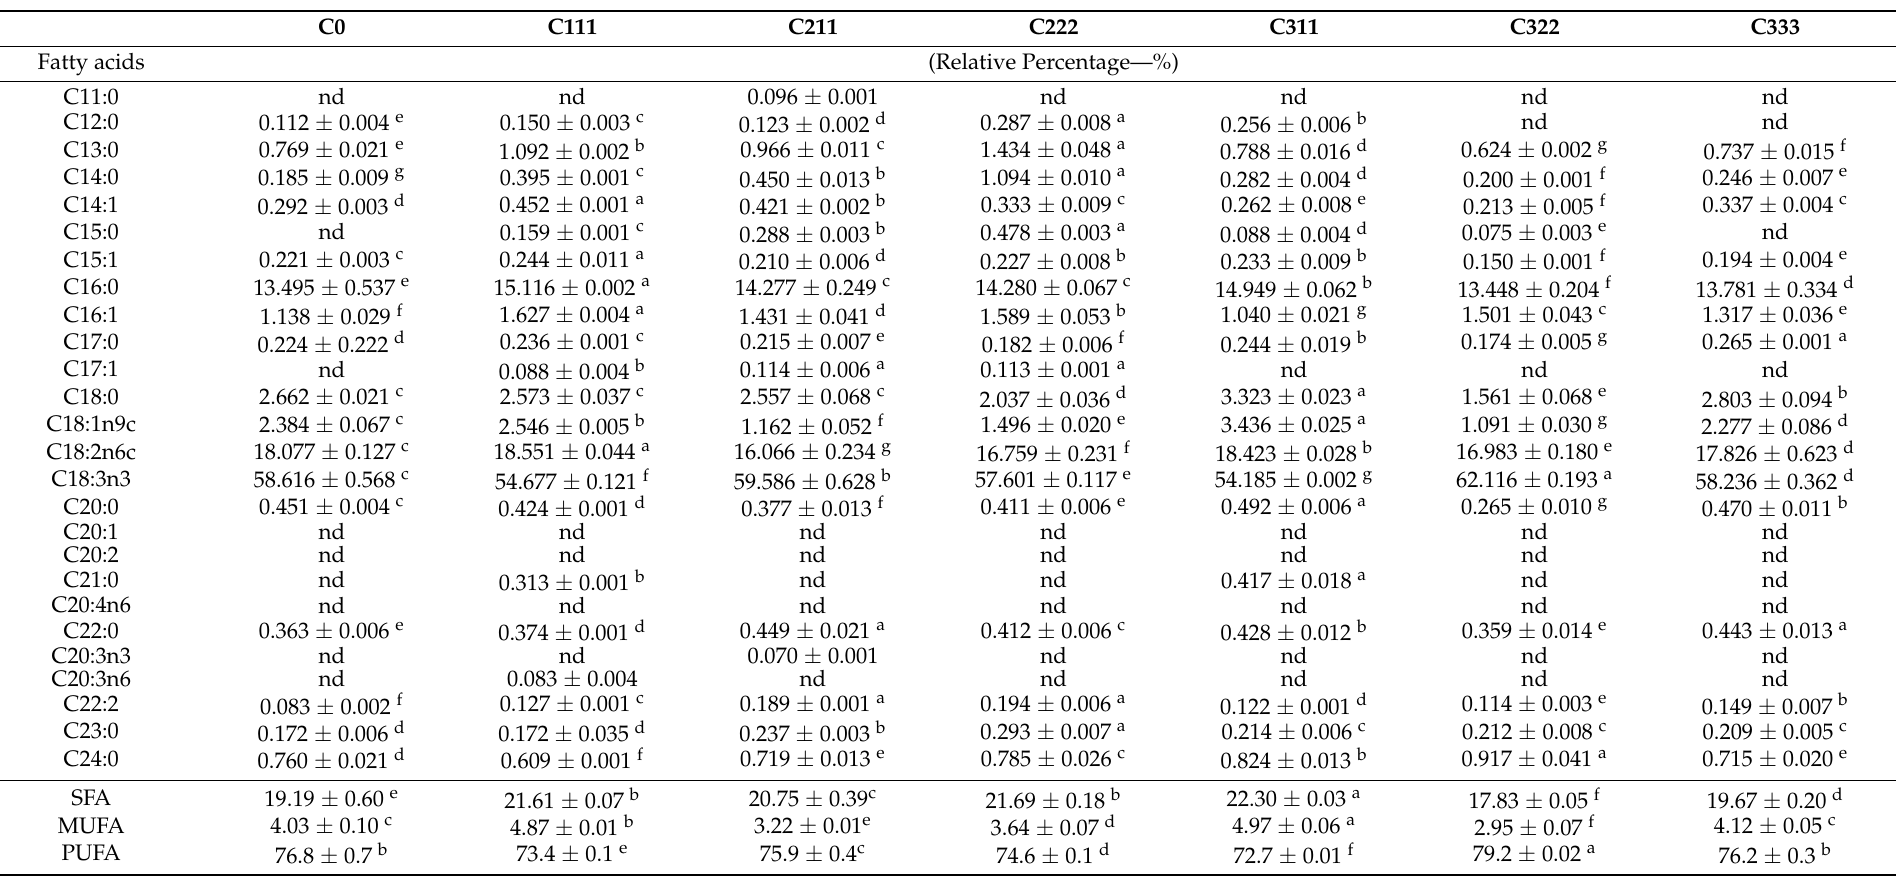
Table 4. Fatty acid composition of C. spinosum (mean ±